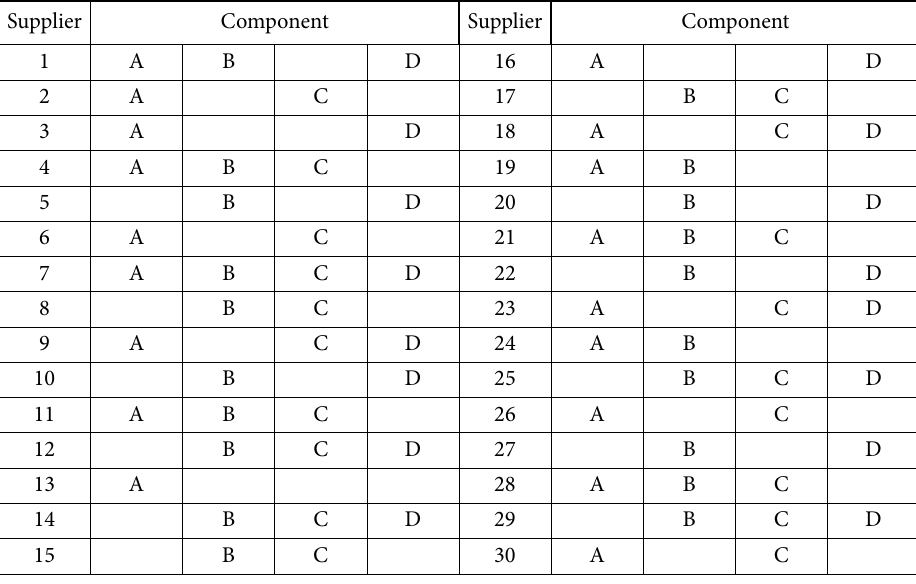
Table 4. Potential suppliers and produced